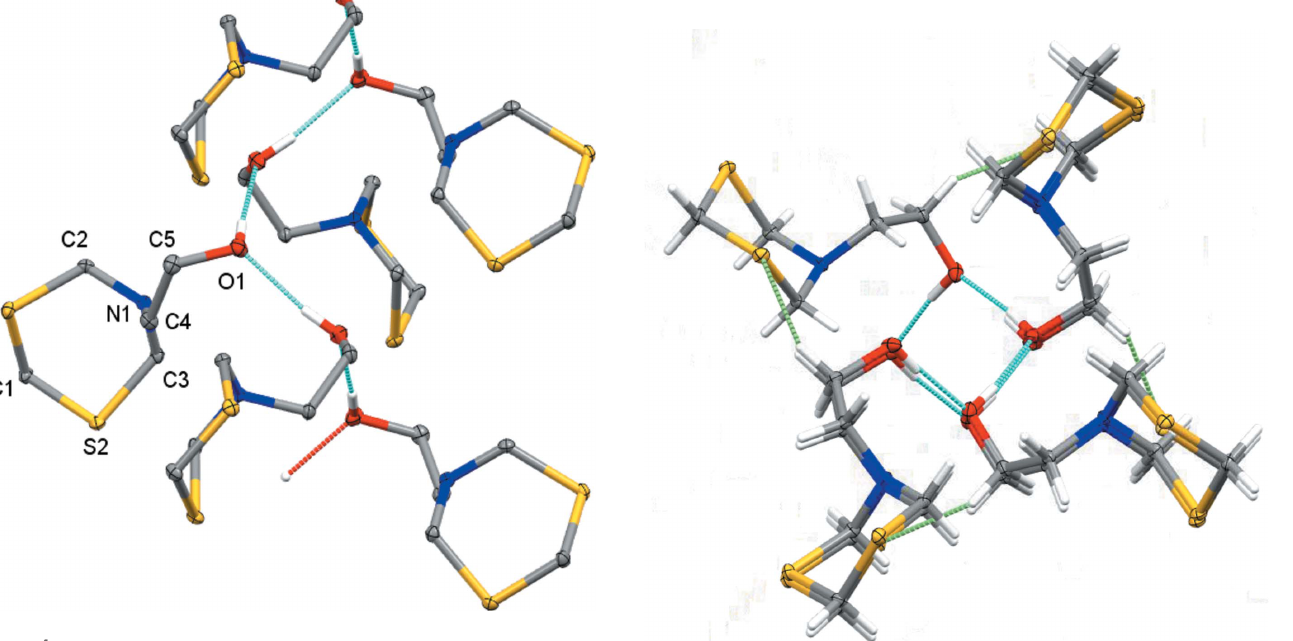
Figure 4 Hydrogen-bonding interactions in the form I polymorph. Molecules are linked into infinite chains that extend along the c -axis direction. Hydrogen-bonded molecules are symmetry-related to each other via the 4 1 -screw axis of the I 4 1 / a space group. Coordinates from Wang et al. (2020). Displacement ellipsoids are shown at the 50% probability level. H atoms not involved in hydrogen-bonding are omitted for clarity.